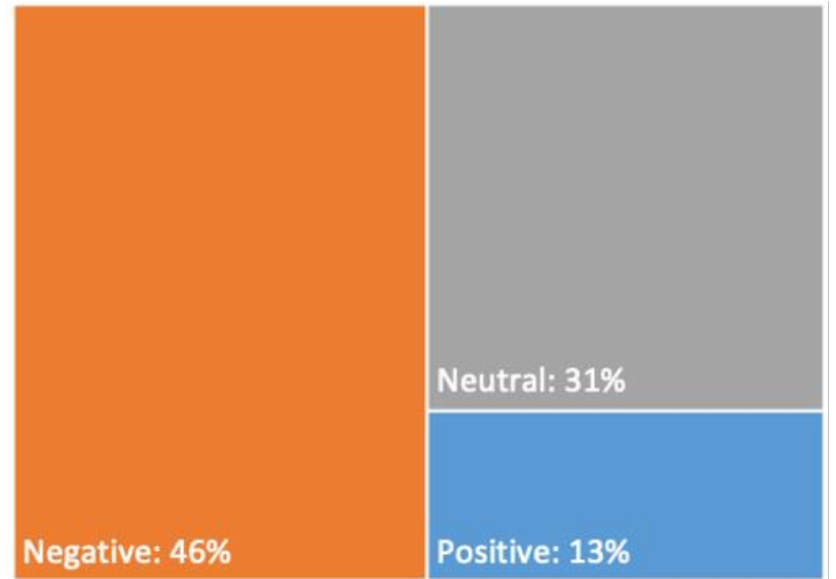
Figure 2. Sentiments of toilet paper-related tweets.